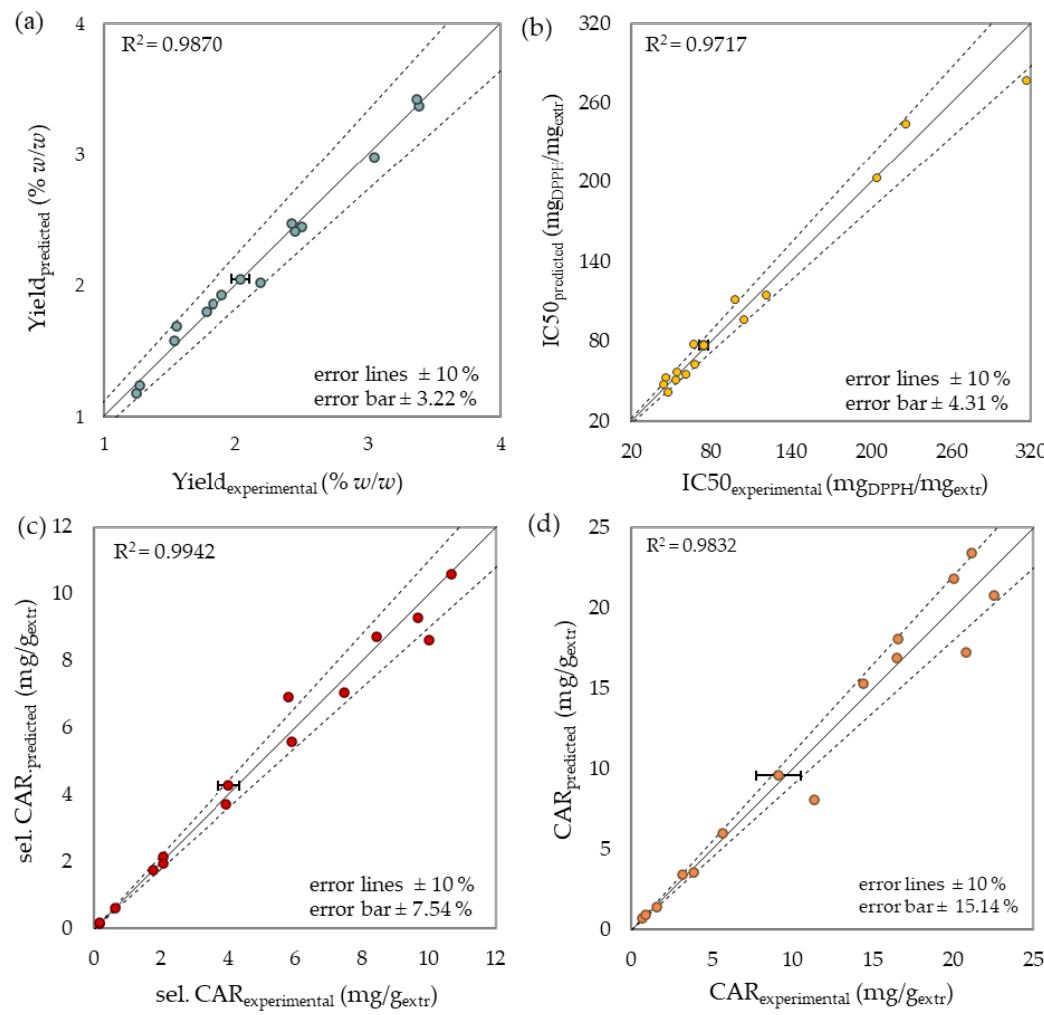
Figure 5. Experimental data versus predicted values of ( a ) yield, ( b ) antioxidant activity, ( c ) selected and ( d ) total carotenoid content. The experimental standard deviation was expressed using the error bars.